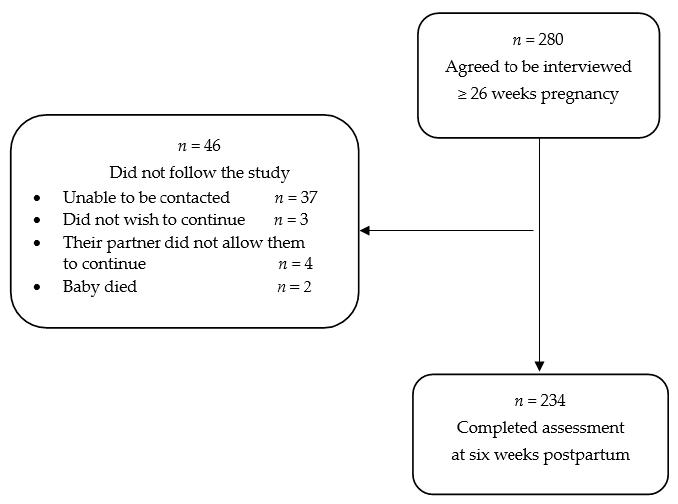
Figure 1. Participant flow diagram.